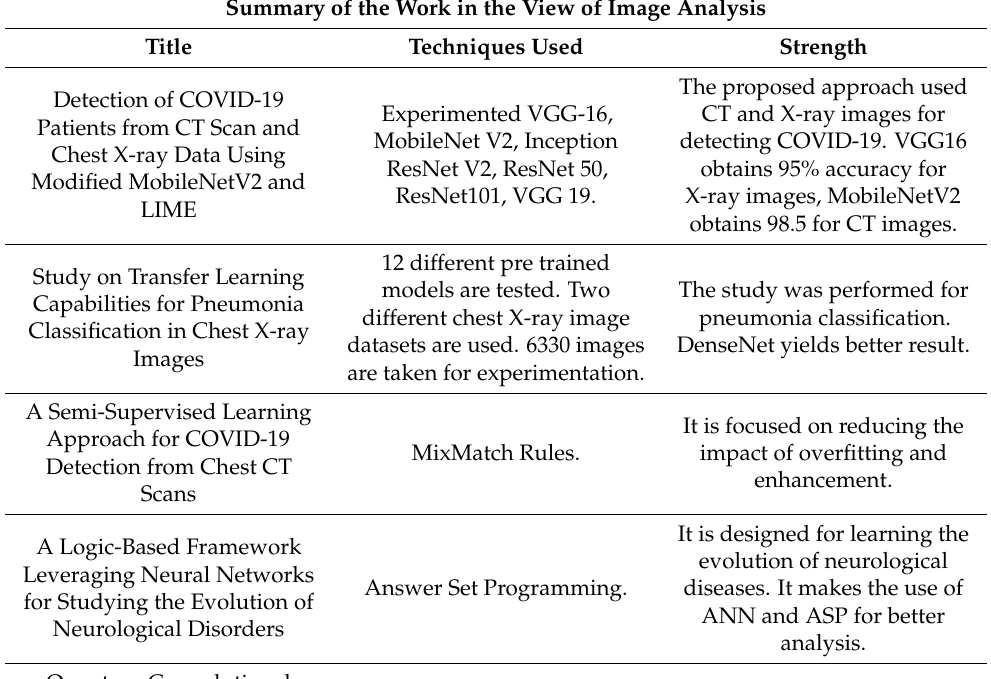
Table 2. Summary of the work in the view of image